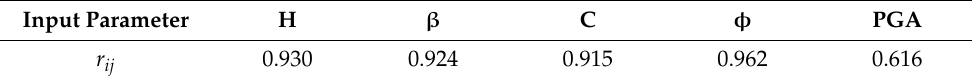
Table 3. Sensitivity analysis of input and output variables.